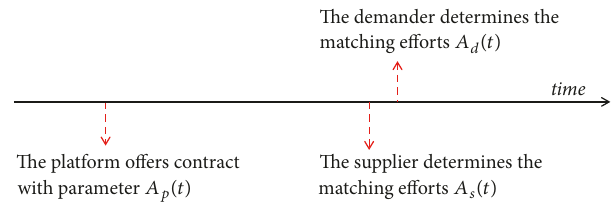
Figure 3: Sequence of events under the decentralised